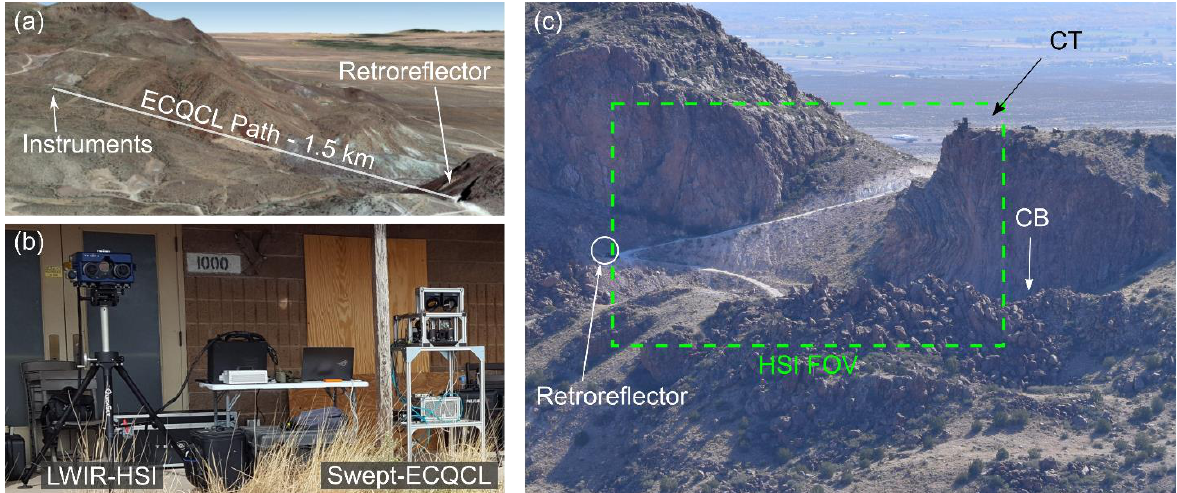
Figure 1. Instrument locations at the plume release site. ( a ) Image from Google Earth showing locations of swept-ECQCL and hyperspectral imaging (LWIR-HSI) instruments, and retroreflector used with the swept-ECQCL instrument. ( b ) Photograph of LWIR-HSI and swept-ECQCL systems during measurements. ( c ) Photographic view looking SE from the vantage point of ECQCL and LWIR-HSI instruments. The cliff-top (CT) plume release location is visible, while the cliff-bottom (CB) location is not visible but lies behind a ridgeline in the foreground of the photograph. The dashed box shows the field of view (FOV) for the LWIR-HSI system, and the circle marks the location of the retroreflector.